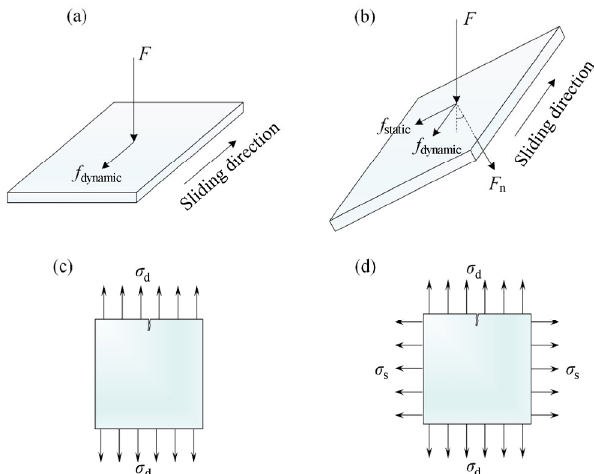
Fig. 10 Schematic diagram of the force decomposition in the friction motion. (a) Friction between polymer sphere and smooth surface with vertical contact; (b) friction between the polymer sphere and an inclined smooth surface; (c) the magnification of the stress state of the element with vertical contact; and (d) the magnification of the stress state of the element with an inclined contact.